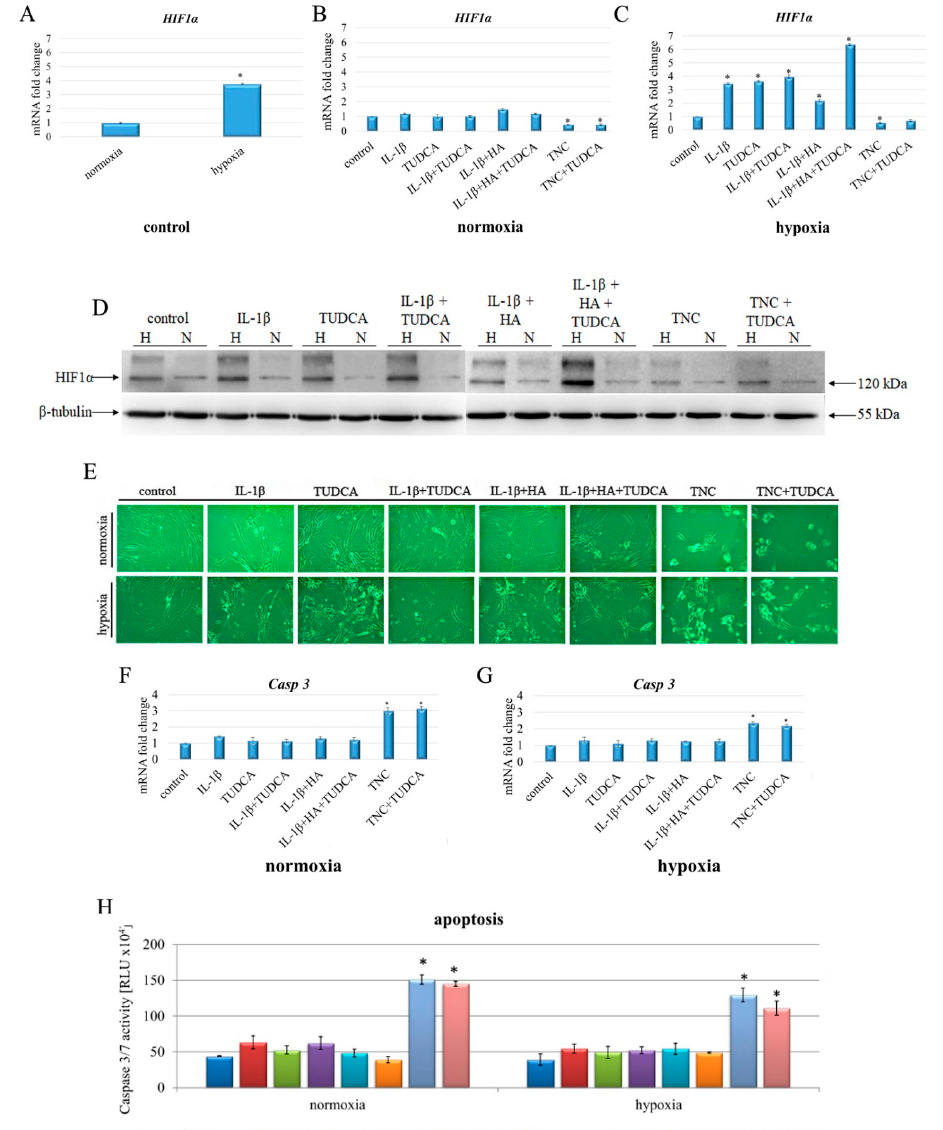
Figure 2. Characterization of hypoxia, cell morphology, and apoptosis in NHAC-kn chondrocyte cells stimulated with IL-1 β , TUDCA, IL-1 β + TUDCA, IL-1 β + HA, IL-1 β + HA + TUDCA, TNC, and TNC + TUDCA for 72 h. Relative quantification